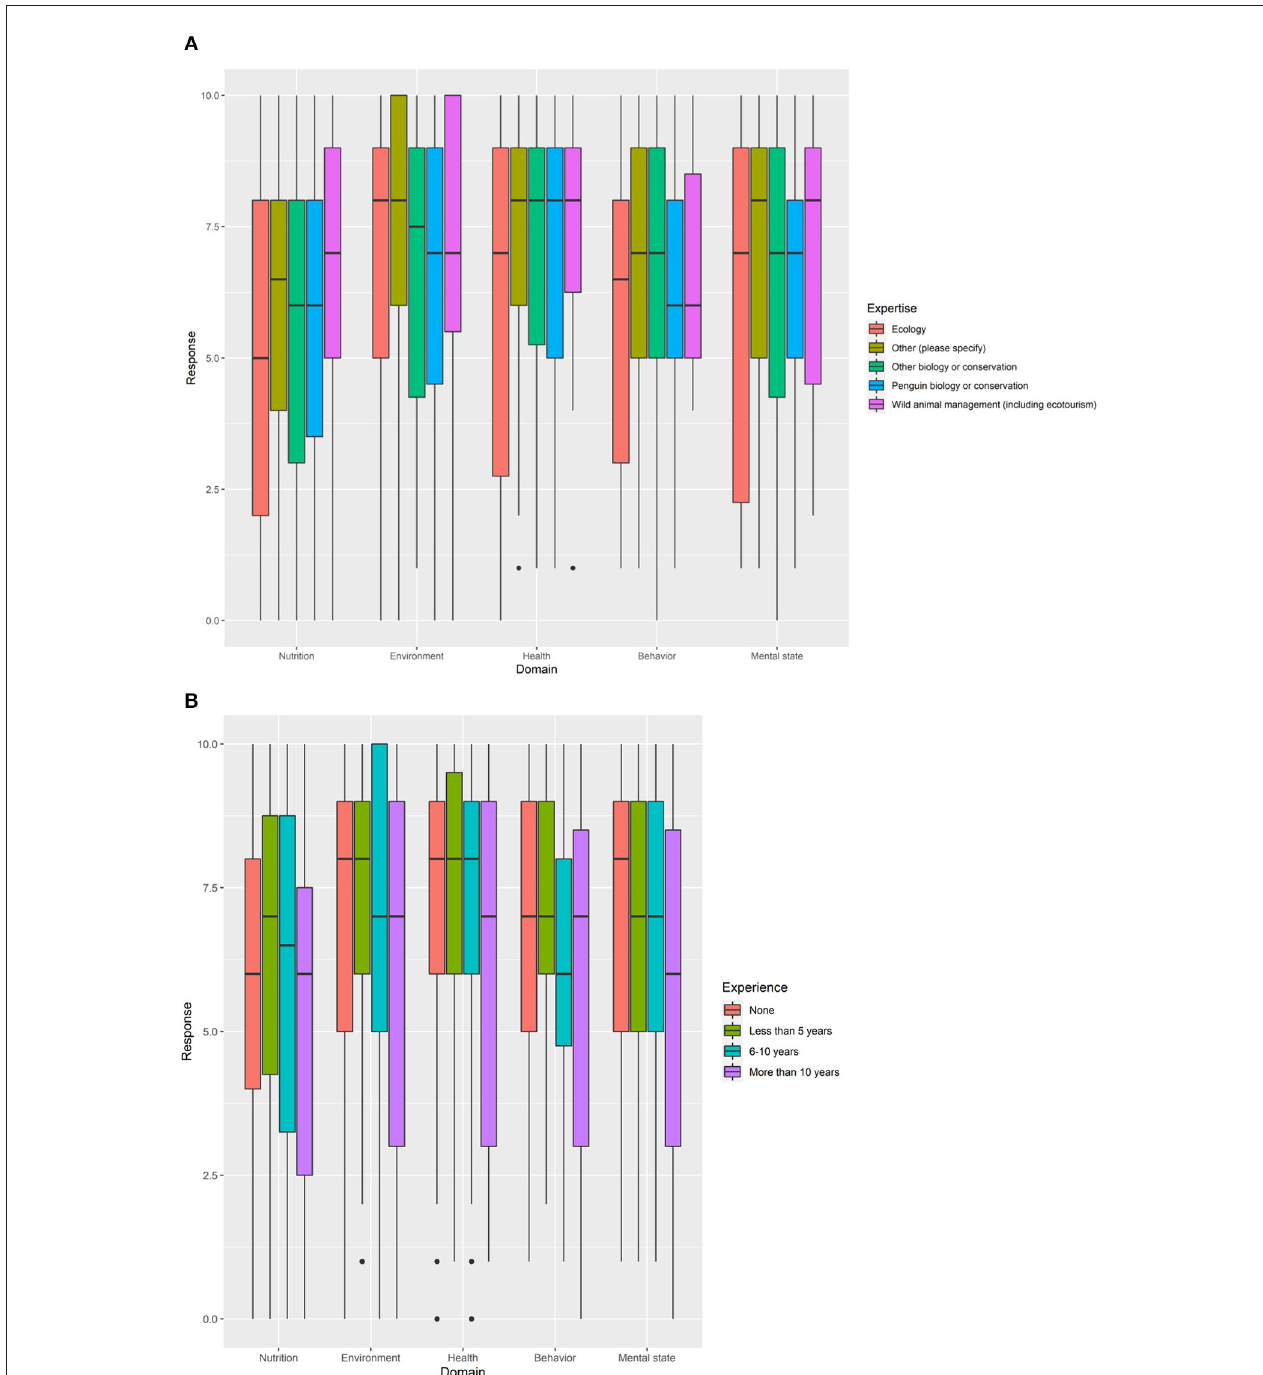
FIGURE 5 | Summary of responses for each domain for participants with different (A) areas of scientific or work interests and (B) levels of experience of working or studying penguins.